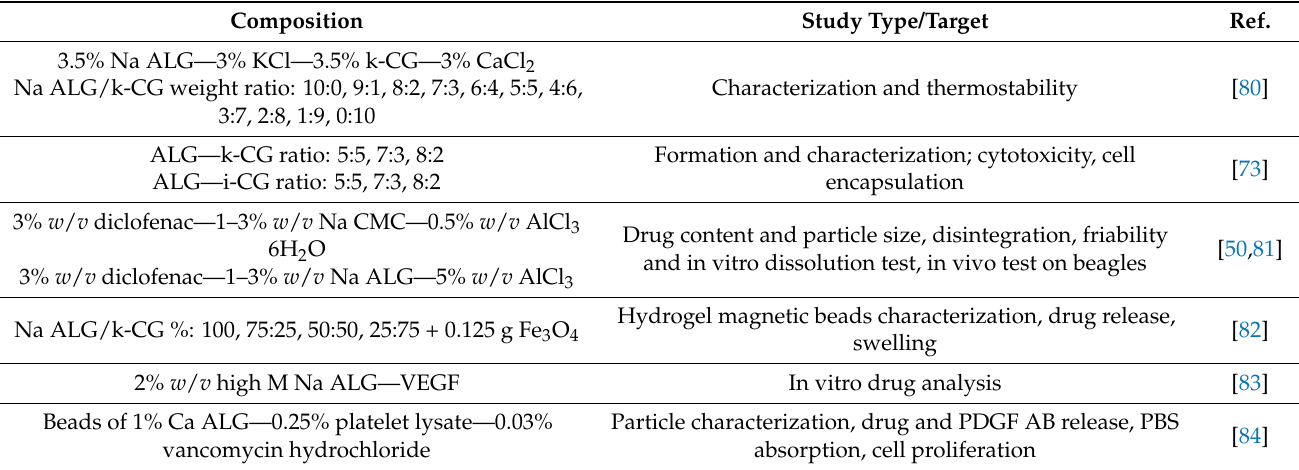
Table 2. Alginate-based beads and microcapsules used for wound healing. Composition Study Type/Target